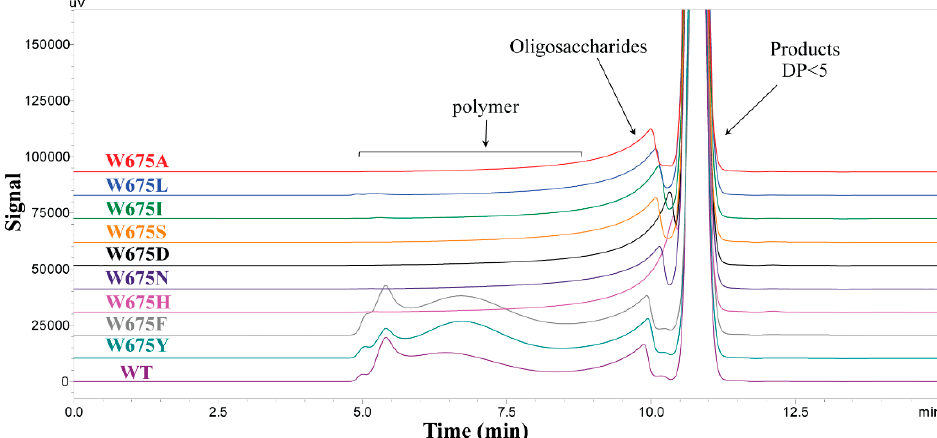
Figure 4. HPSEC analysis of sucrose reaction. The overnight reactions from mutants and WT alternansucrase were analysed using an OHpak SB-805 HQ column and monitored by RI detector.